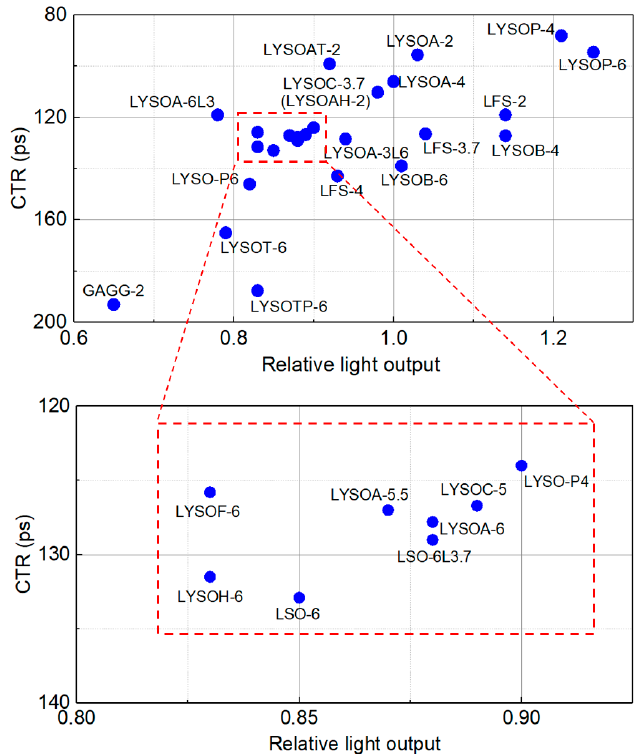
Figure 12. Comparison of the CTR and corrected light output for tested crystals.